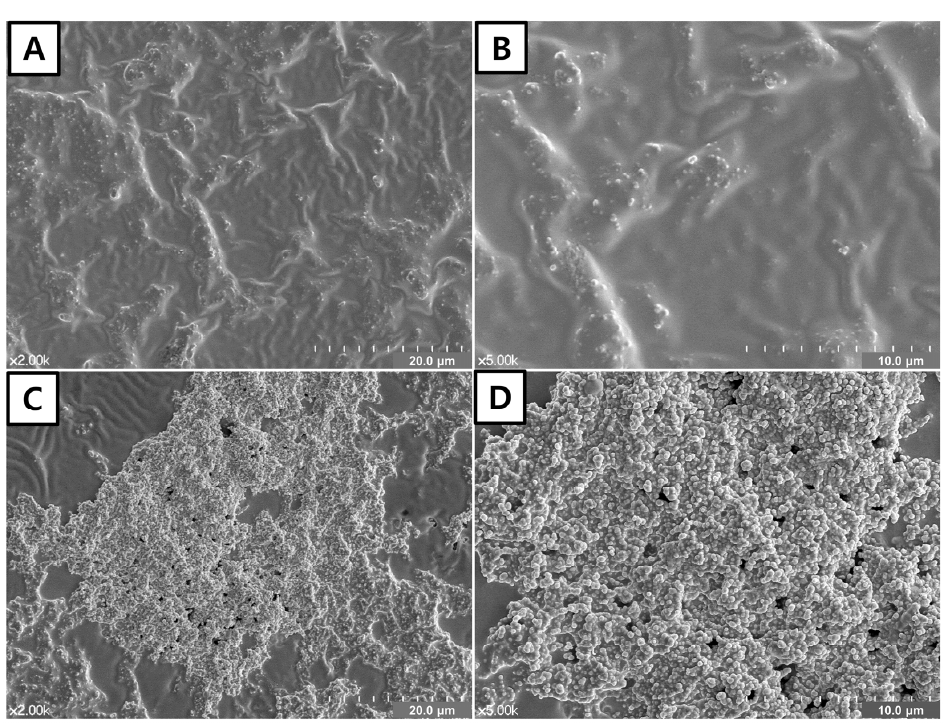
Figure 2. FE-SEM of the adhesive surface. ( A , B ) . Adhesive surface of the SCA group with low and high magnification, respectively. No precipitates were observed on the surface of the SCA group. ( C , D ) . Adhesive surface of BCA group with low and high magnification, respectively. Multiple aggregations of the precipitates were observed.